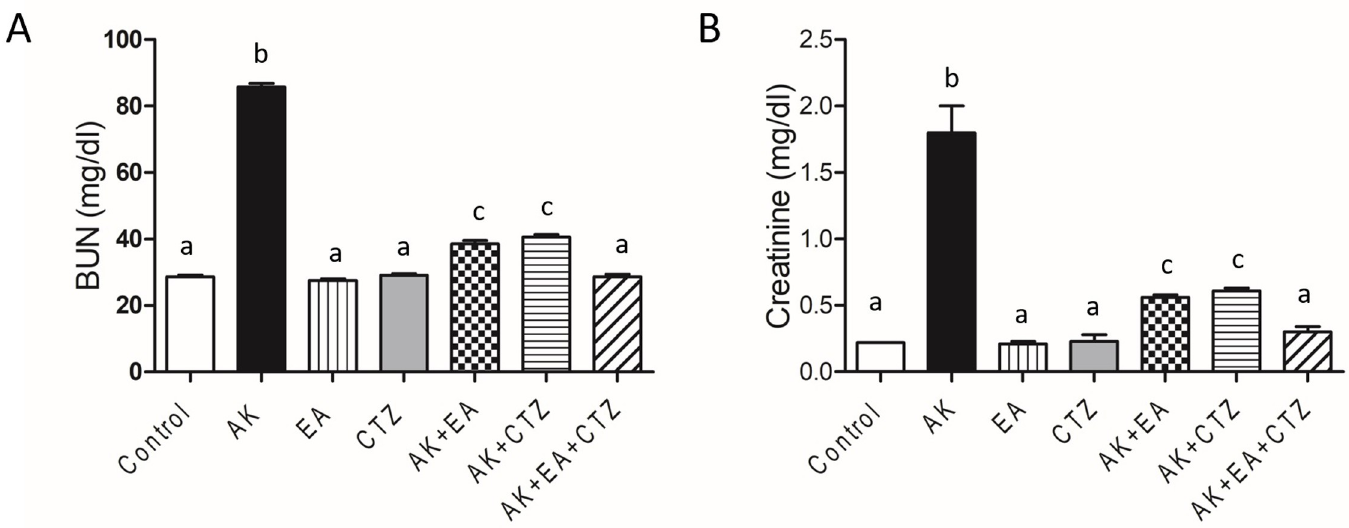
Fig 2. The effect of ellagic acid, cilostazol, and their combination on renal function. Graphical presentation of serum BUN (blood urea nitrogen) (A) and creatinine (B). Ellagic acid (EA) 10 mg/kg, cilostazol (CTZ) 10 mg/kg and their combination were administered one hour before intramuscular injection of amikacin 400 mg/kg for seven days. Groups were compared using one-way ANOVA and post-hoc Turkey ʼ s test. Values are presented as mean ± SE (n = 7). Values without common small letters are significantly different ( p < 0.05).